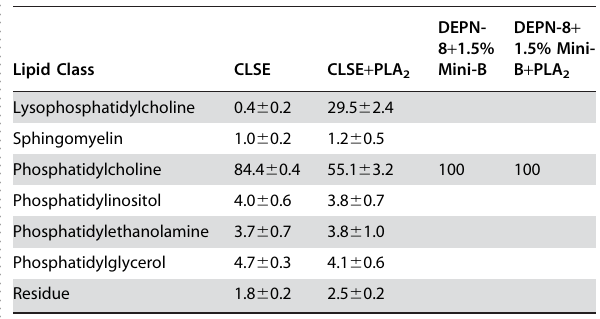
Data are mean 6 SEM for n=3. DEPN-8 + 1.5% by weight Mini-B was incubated in vitro with PLA 2 (0.1 Units/ml) for 30 min at 37 u C, and degradation was assessed by measuring lipid classes in weight percent based on phosphate analysis of bands on thin layer chromatography. Results for CLSE in the presence and absence of PLA 2 utilized identical methods as reported previously by Wang et al